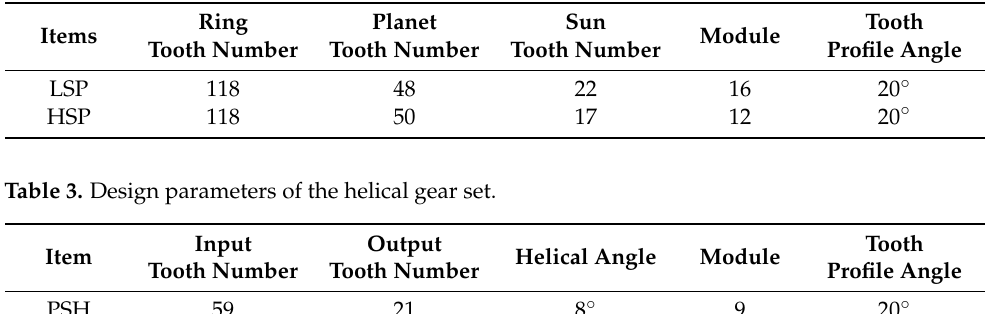
Table 2. Design parameters of the planetary gear sets.